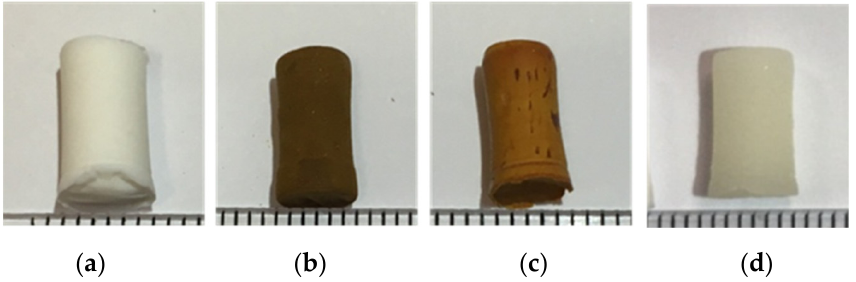
Figure 8. Images of alginate aerogels: alginate aerogels, ( a ) blank, ( b ) Zn(II)-AHBD-impregnated, ( c ) Zn(II)-AHBD + [Aliquat][Cl]-impregnated, ( d ) [Aliquat][Cl]-impregnated.